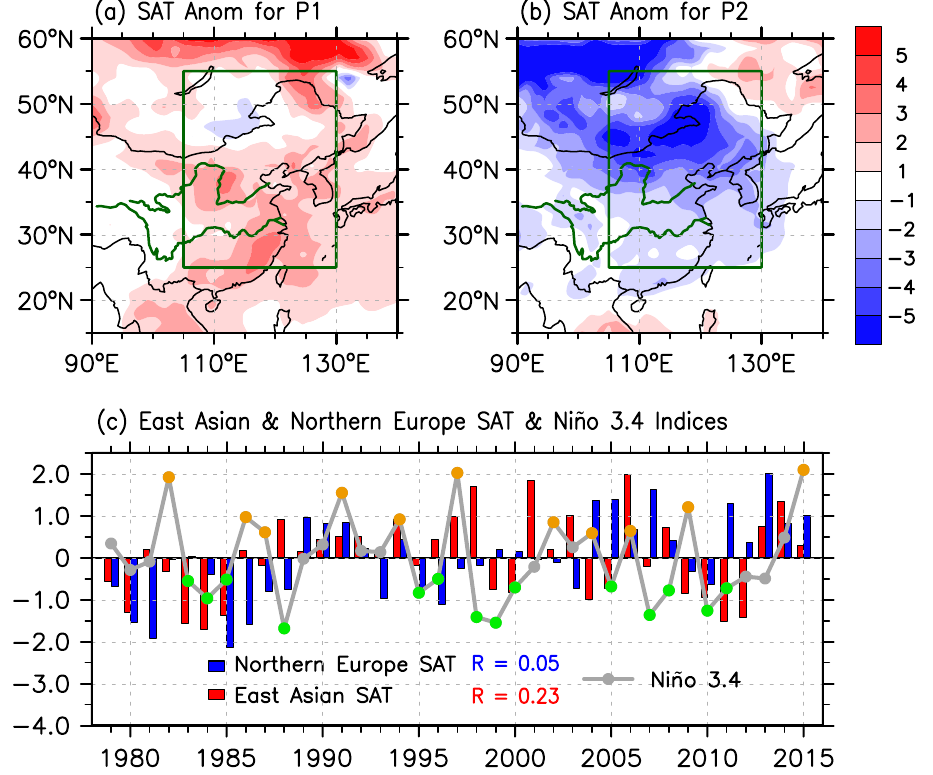
Figure 1. Relationship between ENSO and regional SAT anomalies. Surface air temperature (SAT) anomalies (°C) over East Asia for the period of Dec 19, 2015 to Jan 08, 2016 (P1; a ) and Jan 12, 2016 to Jan 25, 2016 (P2; b ). The green box in ( a ) and ( b) outlines the domain used as the definition of the East Asian SAT index. ( c ) Time evolution of the normalized anomalous East Asian SAT (red bar), Northern Europe SAT (blue bar), and Niño 3.4 (dotted grey curve) indices (°C) during boreal winter (DJF mean) from 1979 to 2015. Here, the winter of 1979 refers to the 1979/80 winter. Orange, green, and grey dots indicate El Niño, La Niña, and normal winters, respectively. Red (Blue) “R” in ( c ) refers to the correlation coefficient between Niño 3.4 and East Asian (Northern Europe) SAT indices. The figure was generated with the NCAR Command Language (Version